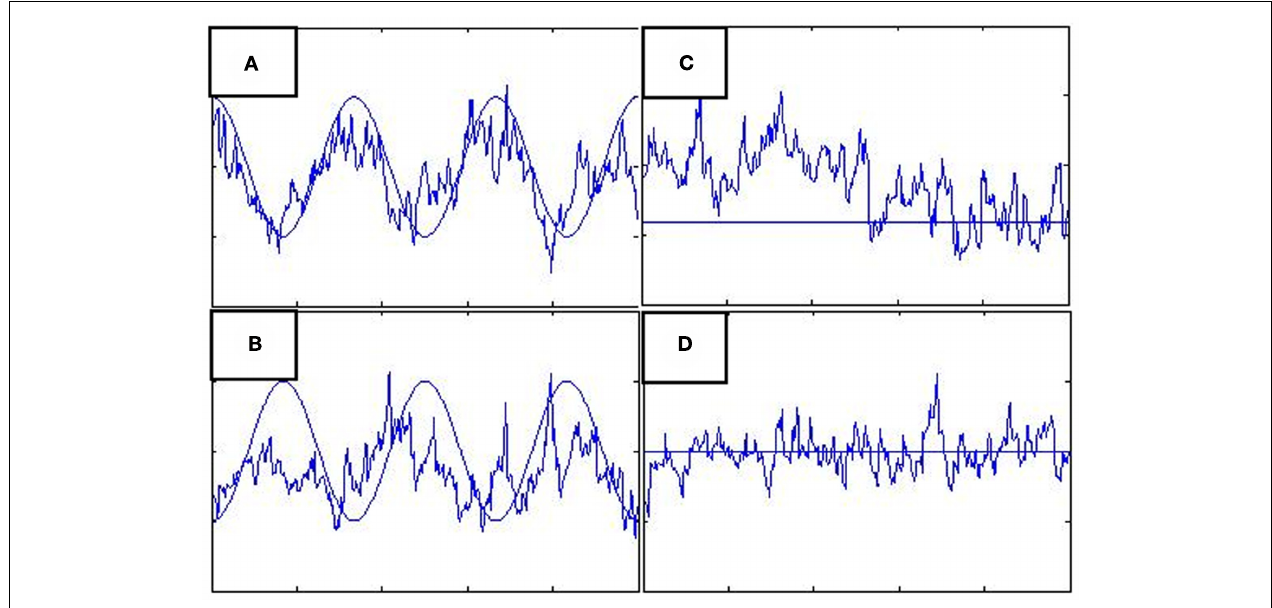
FIGURE 2 |Actual connectivity parameter values from simulation (smooth lines) versus LDSf parameter estimates using the joint model (jagged lines). True parameter values in (A,B) vary according to sine waves while true parameter values in (C,D) are